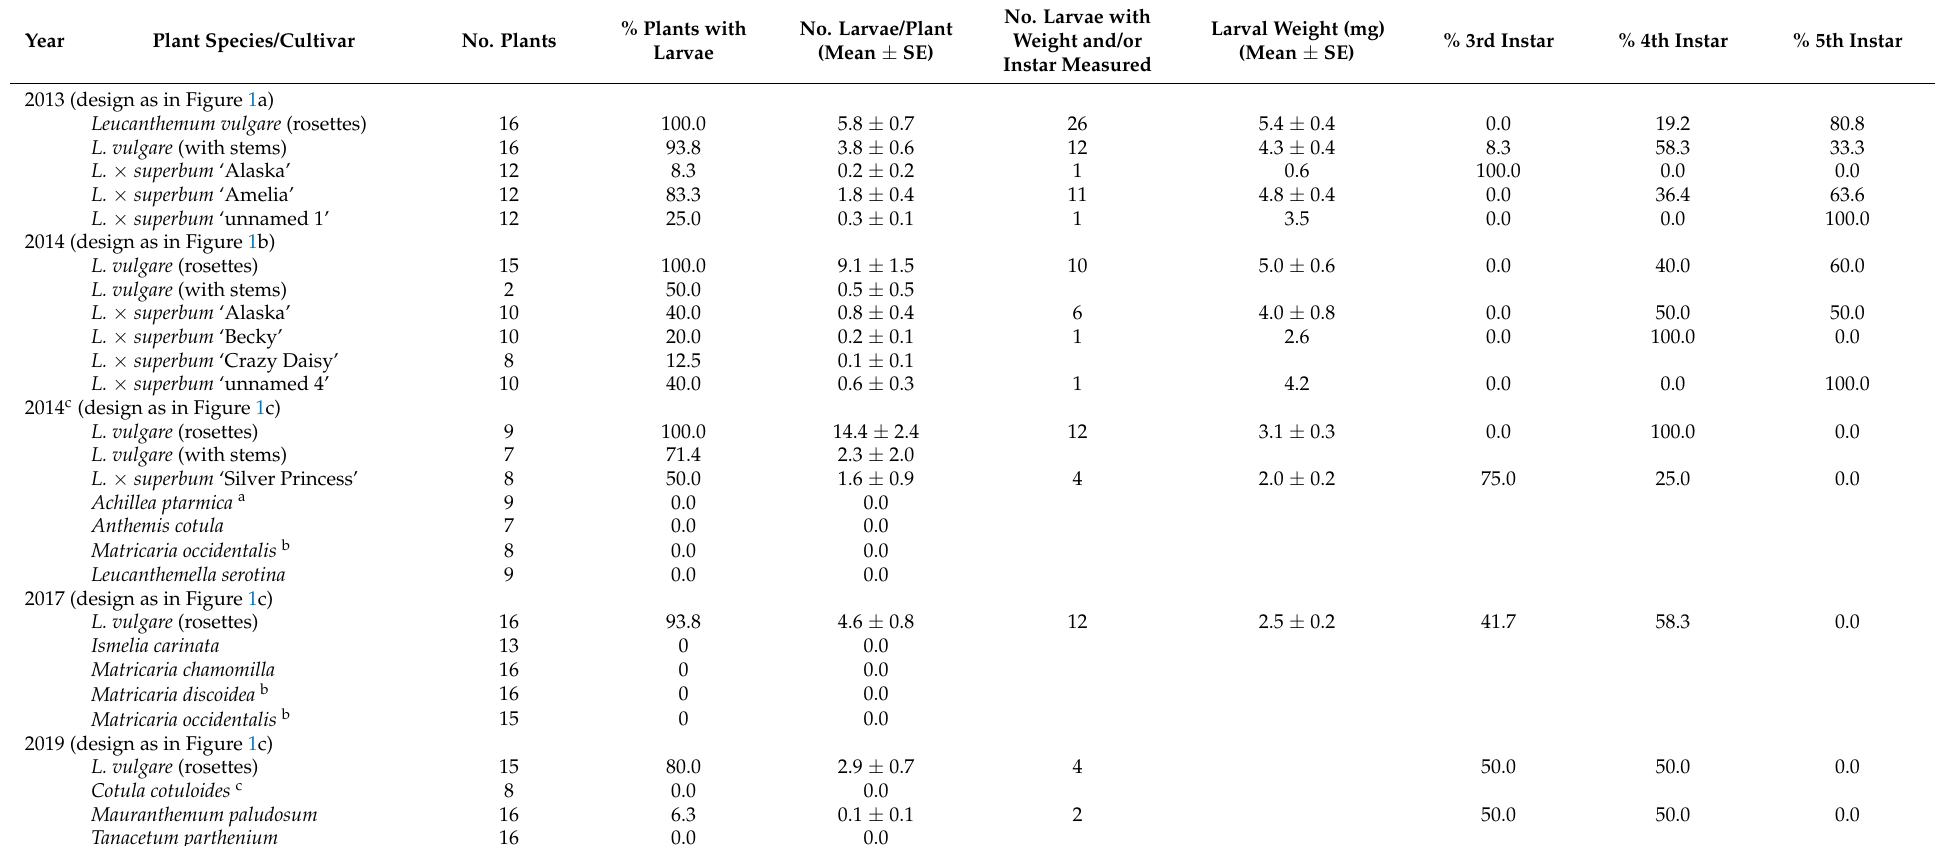
Table 3. Results of multiple-choice open-field tests conducted in 2013, 2014, 2017 and 2019. In April or May, 20 to 25 egg-laying females of Dichrorampha aeratana were released at the central point of each test. The plants were exposed for 2–4 weeks and dissected in autumn. Most Leucanthemum plants were in the rosette stage, while many of the other plants were already bolting or